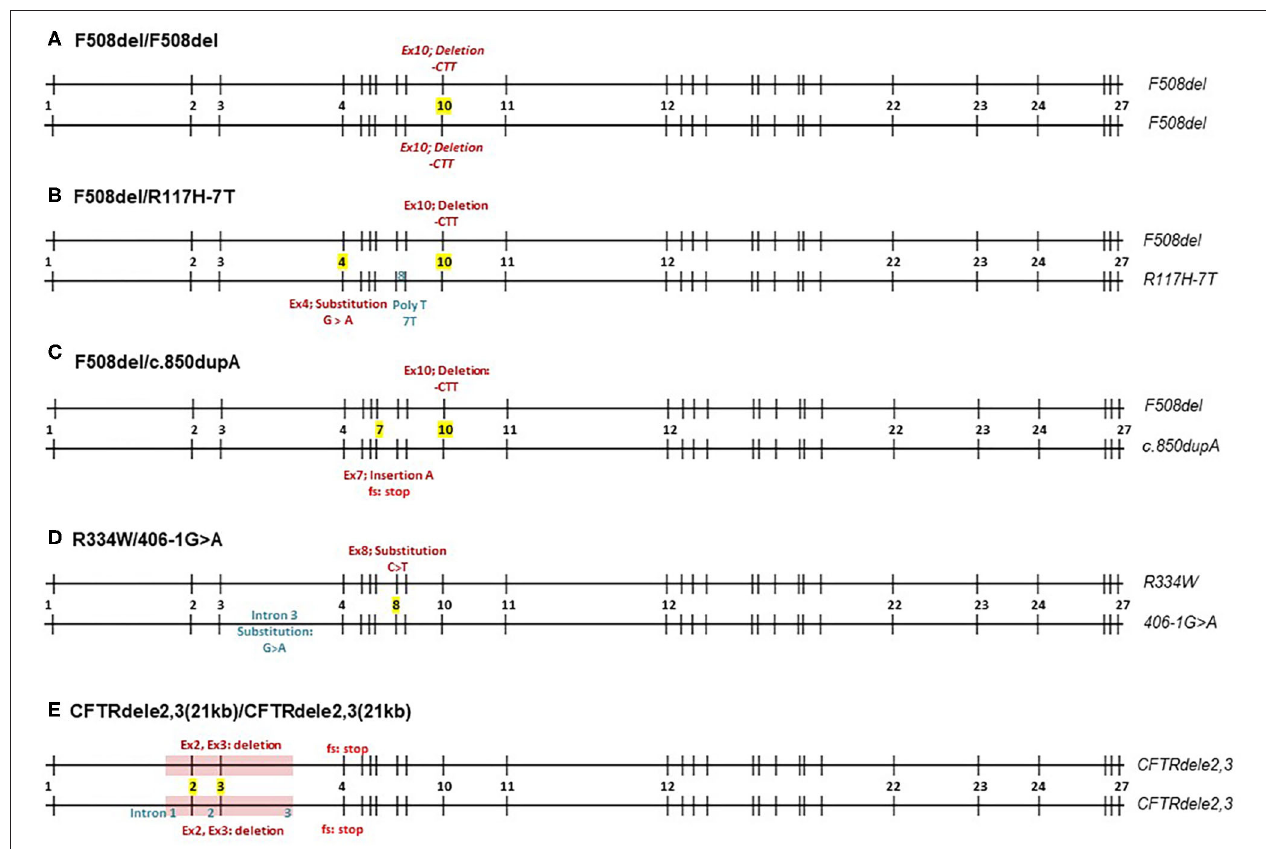
FIGURE 1 | Schematic overview of CFTR mutations by five different CF genotypes. Numbers 1-27 represent exons of the CFTR gene. (A–E) F508del homozygote, F508del/R117H-7T, F508del/c.850dupA, R334W/406-1G > A, and CFTRdele2,3(21kb) homozygote.